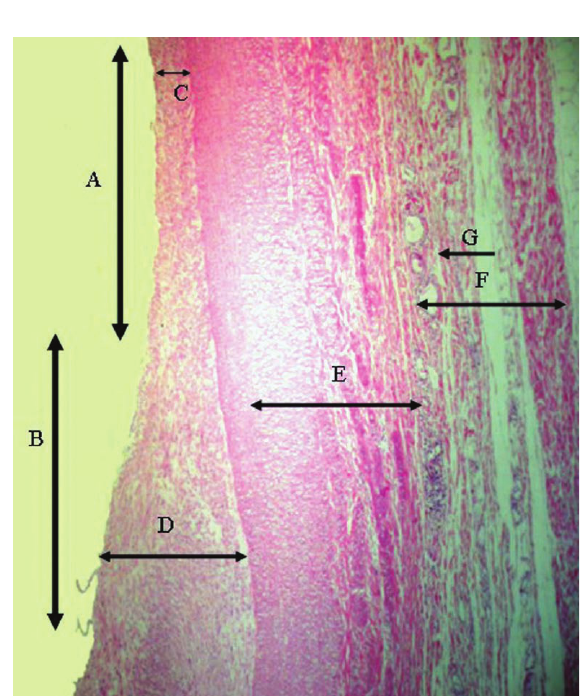
Fig. 6 - Corte histológico longitudinal de transição entre o segmento normal da aorta (seta A) e o segmento imediatamente antes do início do stent (seta B) da aorta dos suínos: A e B - correspondem à luz da aorta; C - camada íntima com espessura normal (endotélio + tecido conjuntivo frouxo + elástica interna); D - camada íntima espessada (extremidade mais próxima do stent), com acúmulo de fibroblastos e colágeno; E - camada média (muscular), contendo células musculares lisas; F - camada adventícia contendo células adiposas, tecido conjuntivo frouxo e vasa vasorum; G - vasa vasorum (100X HE).